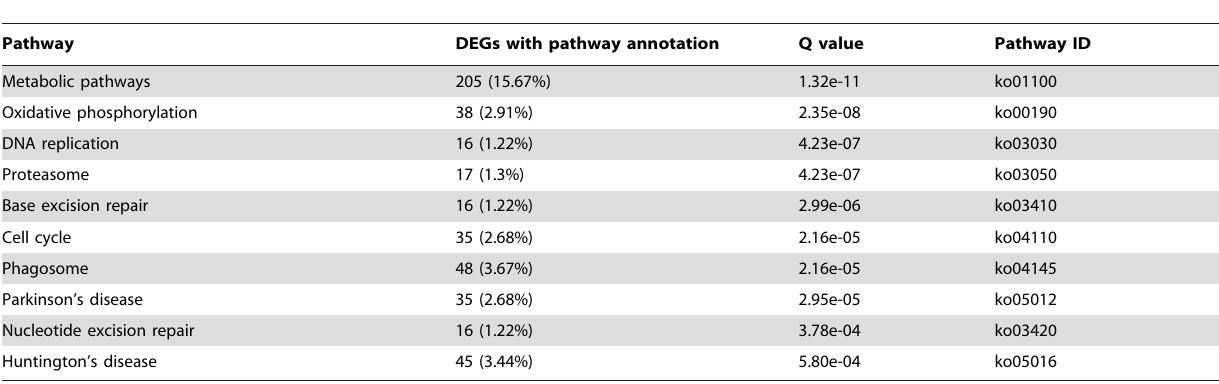
Table 4. Top 10 significantly enriched pathways in differentially expressed genes at + 3 d compared with 2 35 d.